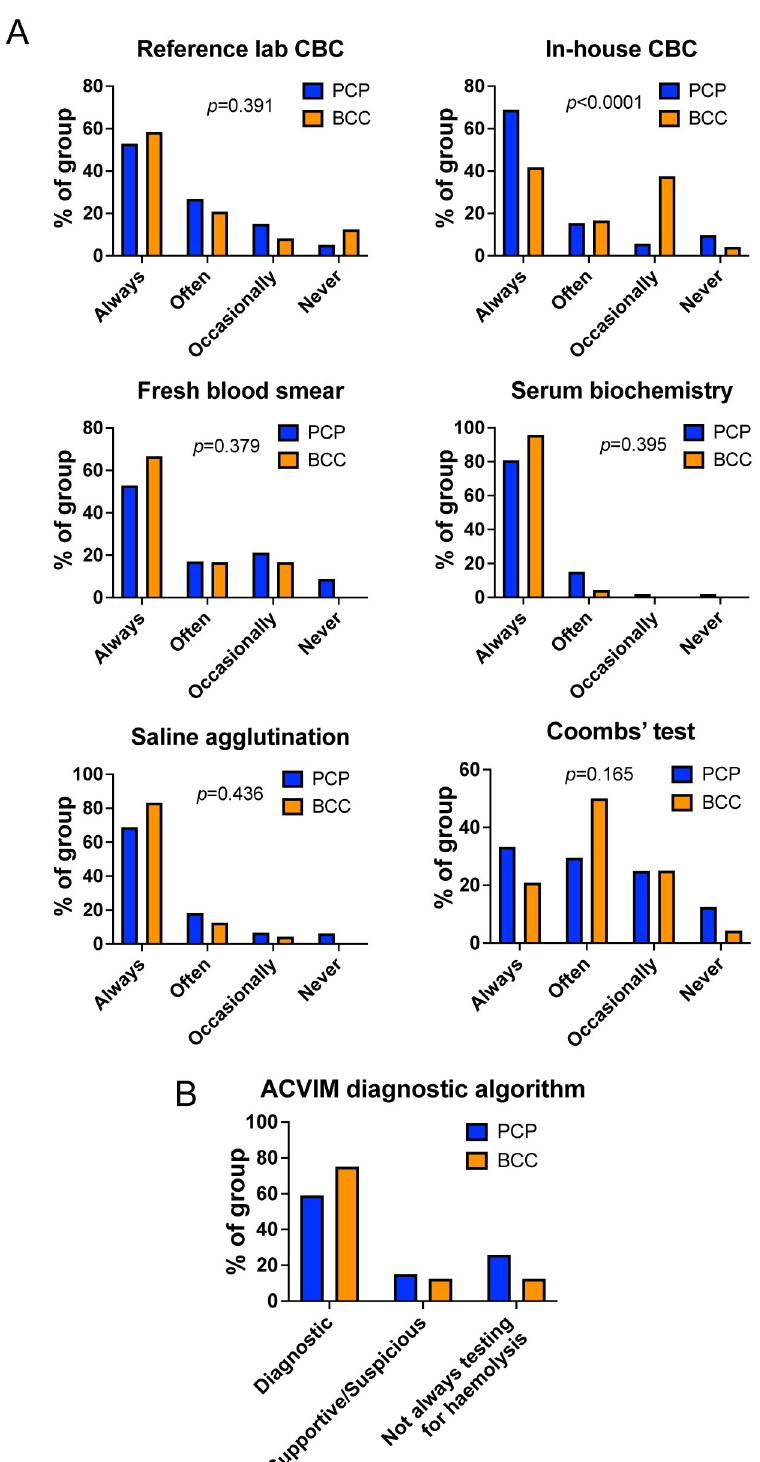
Fig 2. Respondents in primary care and referral practice have a similar approach to diagnosis of IMHA. (A) Graphs showing percentage of either board-certified clinicians (BCC, n = 24) or respondents in primary care practice (PCP, n = 193) that reported use of the named tests for diagnosis of IMHA, Chi-squared or Fisher’s exact tests. CBC: complete blood count. (B) Graph showing proportion of respondents in each group that always performed sufficient tests for different categories of diagnostic confidence for IMHA as outlined in the ACVIM consensus statement [3]. https://doi.org/10.1371/journal.pone.0257700.g002 PLOS ONE | https://doi.org/10.1371/journal.pone.0257700 September 20,